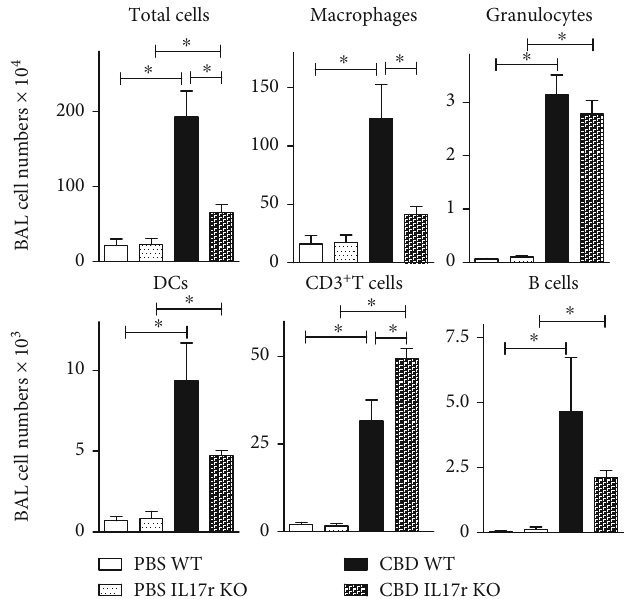
Figure 7: IL-17R signaling is important for CBD in fl ammation. Quanti fi cation of fl ow cytometric analyses of the indicated populations of BAL cells in four groups of mice 8 weeks after initial exposure. The results shown are expressed as the means ± SEM and represent one out of two independent experiments with 3-4 mice per group. Mann-Whitney U test: ∗ p < 0 : 05